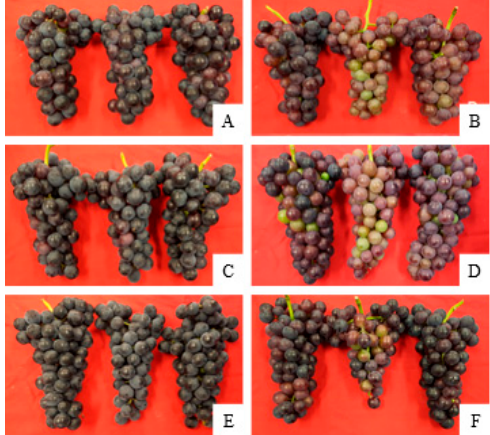
Figure 22. Development status of grape granules according to solar-module installation. ( A ) Normal control site, ( B ) normal solar-panel site, ( C ) bifacial control site, ( D ) bifacial solar-panel site, ( E ) transparent control site, and ( F ) transparent solar-panel site. ( E ) transparent control site, and ( F ) transparent solar-panel site.